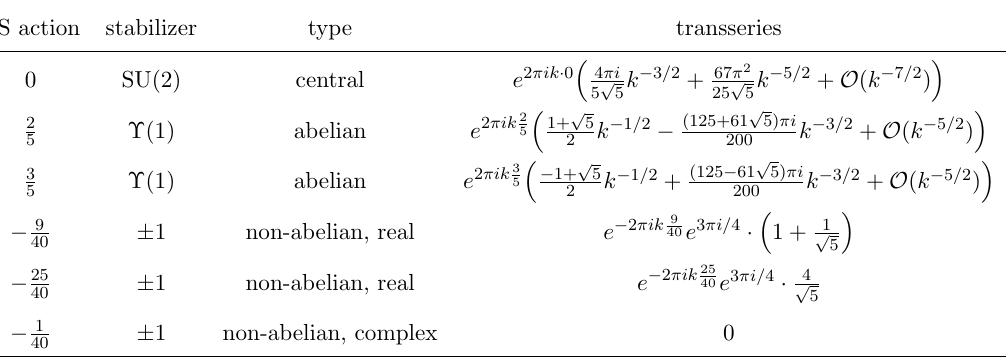
1; 1 ; 1 ; 1 ) up to an overall 2 5 5 (cid:0)